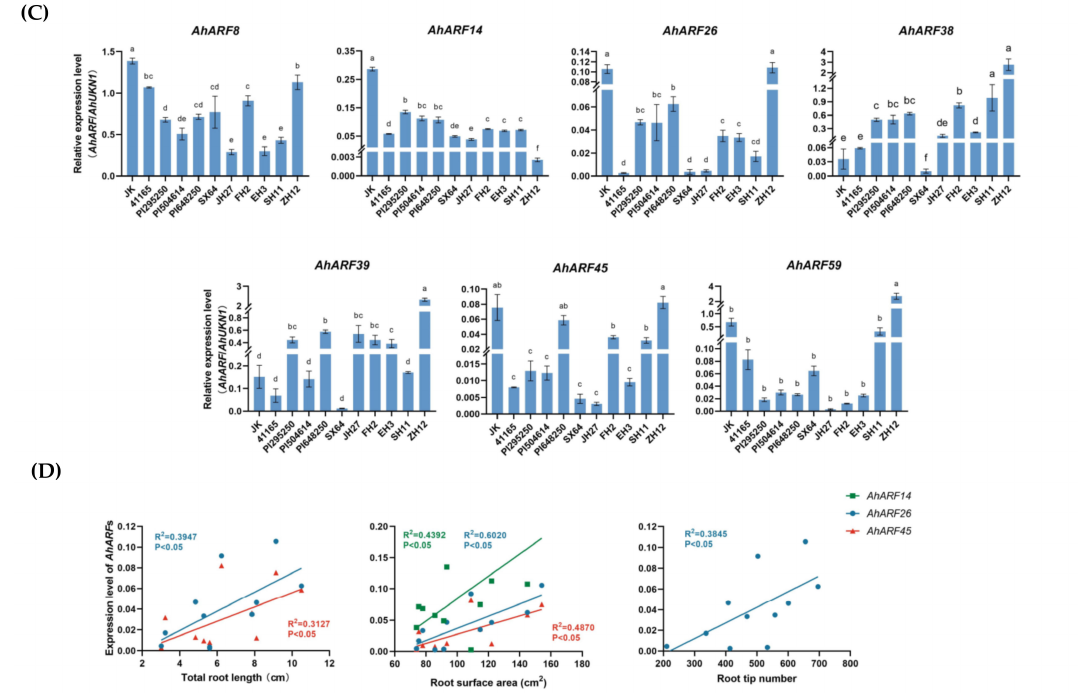
Figure 6. Root morphology and their correlation with AhARF expression levels in peanut germplasms. ( A ) Root morphology of peanut germplasms. JK, Jinkins Jumbo; 41165, Meiyinxuan 41165; SX64, Shix- uan 64; JH27, Juhua 27; FH2, Fenghua 2; EH3, Ehua 3; SH11, Shanhua 11; ZH12, Zhonghua 12. ( B ) Total root length, root surface area, root mean diameter, and root tip number of peanut germplasms. Lower case letters (a, b, c, d) indicate statistically significant differences between cultivars. ( C ) Relative expression levels of AhARF s in peanut roots. ( D ) Pearson’s correlation analysis between root morphology and expression of AhARF s. R 2 , Pearson’s correlation coefficient.